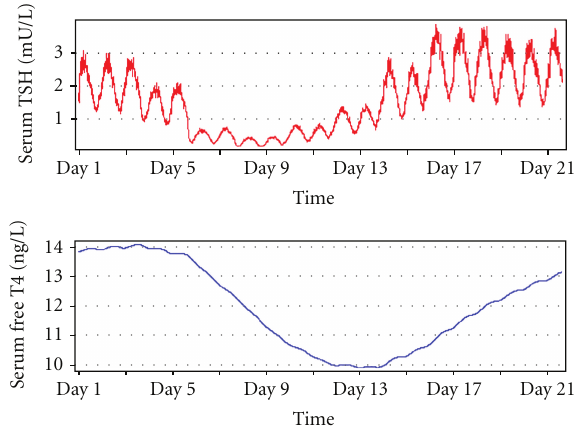
Figure 7: Computer simulation of thyrotropic adaptation in critical illness. A gradual increase of central type 2 deiodinase activity over several days with subsequent restoration to normal values has been simulated with SimThyr using the mathematical model shown in Figure 2. Note the temporarily increased TSH values after day 17 that are occasionally observed also in vivo in patients recovering from nonthyroidal illness